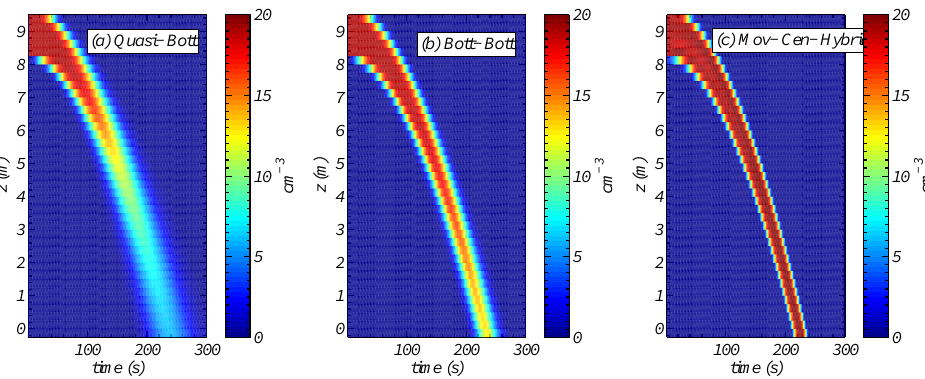
Fig. 2. Shows the evolution of ice crystal concentration for each of the different representations of the model bin-advection and vertical advection. Panel (a) shows the quasi-stationary algorithm together with 8th order Bott advection in the vertical; (b) shows 8th order Bott advection for both bins and vertical advection; and (c) shows the moving centre algorithm together with a two moment advection scheme. It can be seen that scheme (a) artificially reduces the peak concentration by a factor of three; (b) is less diffusive, but still reduces the concentration by a factor of about 1.5; (c) maintains the peak in concentration.